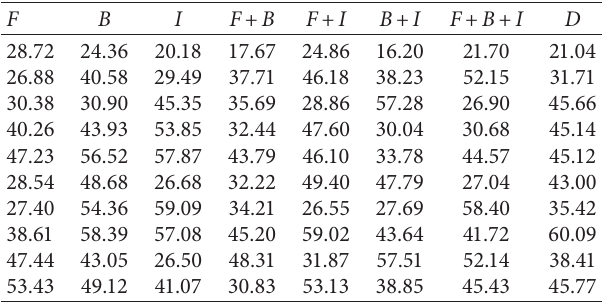
Table 6: Average accuracy of discrete